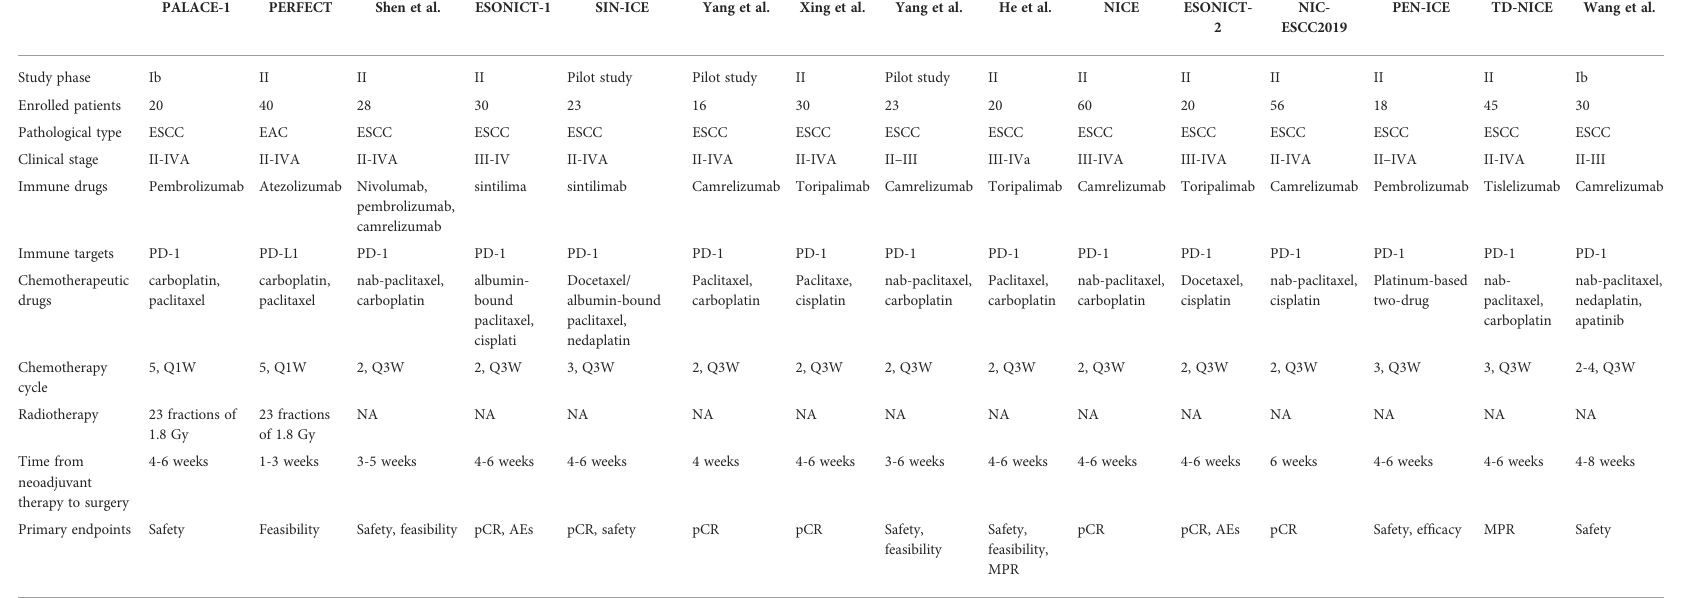
TABLE 1 Reported clinical trials of neoadjuvant immunotherapy for the treatment of resectable esophageal